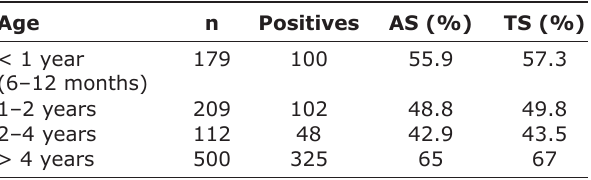
Table-2: AP and PR of IBR by age groups in cattle from Sotaquirá, Boyacá.